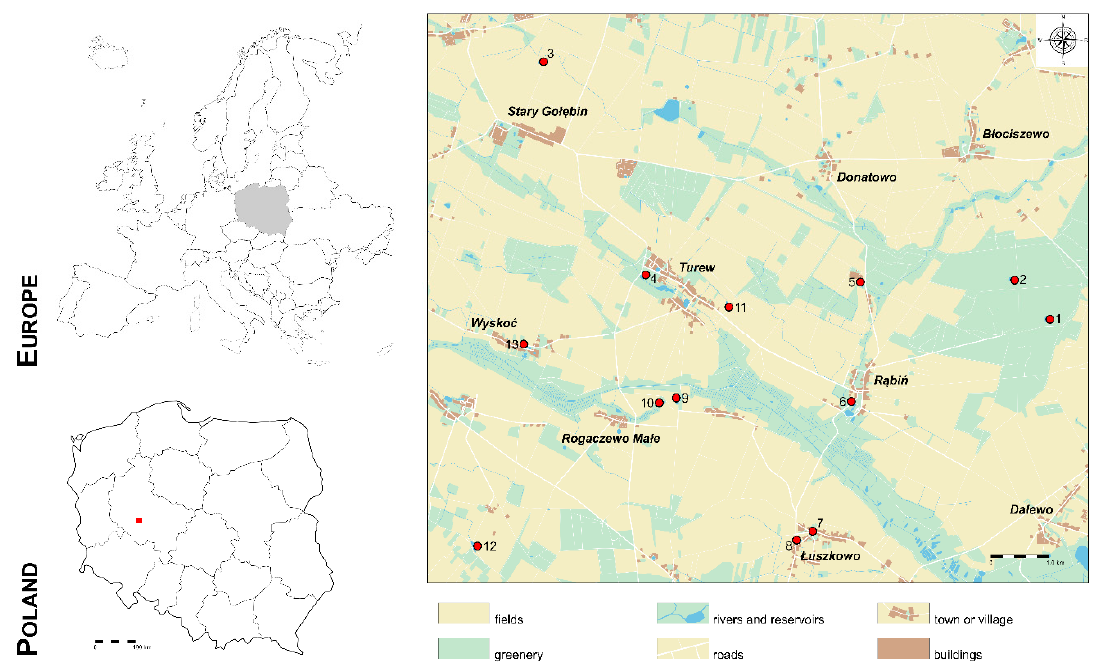
Figure 1. The location of the research objects.